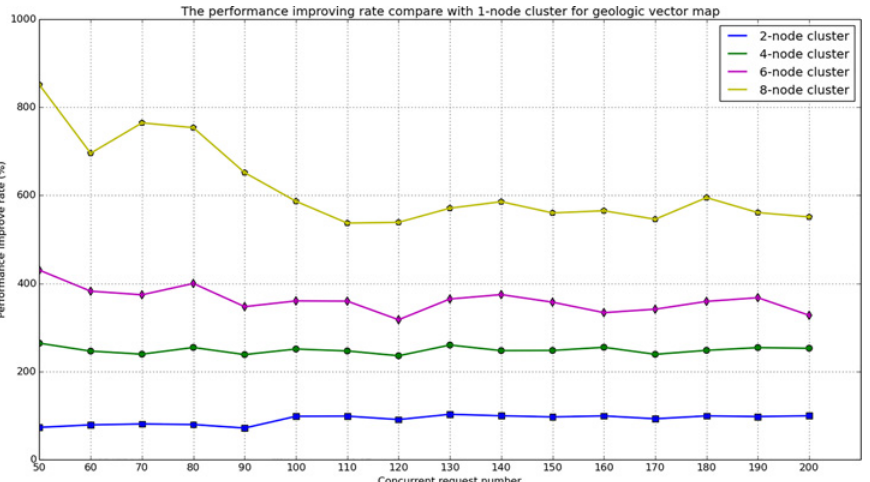
Fig 21. Performance improving rate of vector map service compared with 1-node